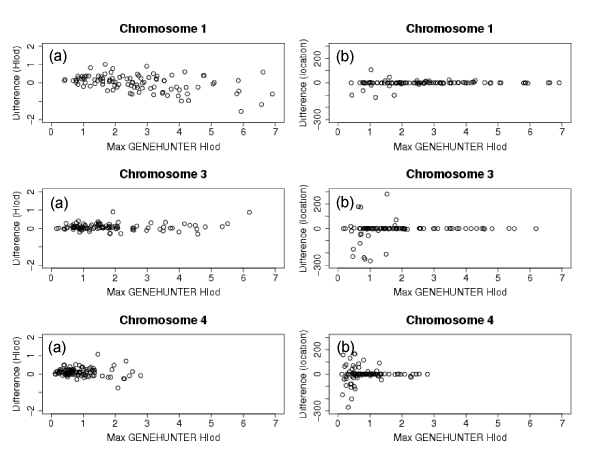
Differences in peak HLOD scores and differences in inferred locations of trait locus. (a) Difference between the GENEHUNTER peak HLOD score and the CHROM-WALK peak HLOD score against the GENEHUNTER peak HLOD score for analyses of data on chromosomes 1, 3, and 4. (b) Difference between the chromosomal locations of the peak HLOD scores against the GENEHUNTER peak HLOD score for analyses of data on chromosomes 1, 3, and 4. Each point represents results from the analysis of a single data replicate for marker set MsetAll.